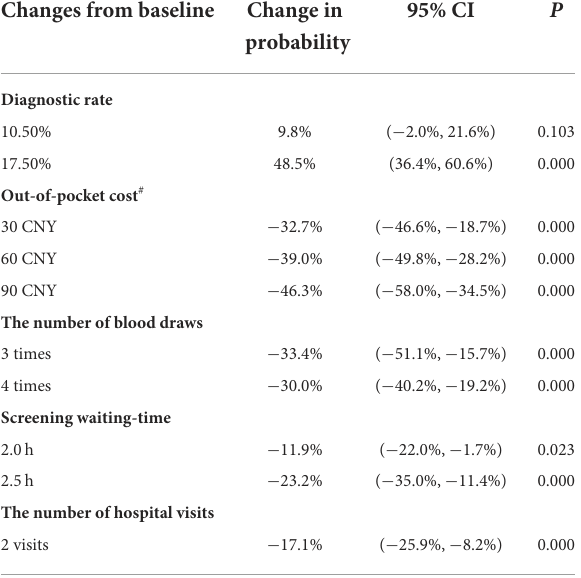
TABLE 5 Results of interaction estimates of individual characteristics and the participant’s preferences with observations =